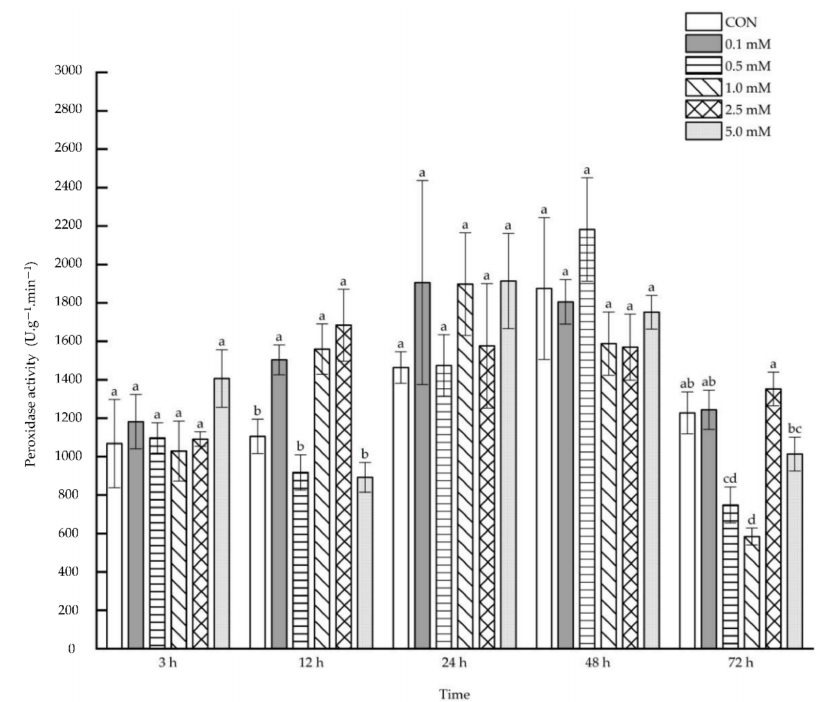
Figure 10. The systemic effect of the SA concentration and post-treatment time on the peroxidase activity in roots following exogenous foliar application. The data are presented as mean ± standard errors. The significance of data was determined by the Duncan method. The difference between different letters at the same time reached significant levels of 5%.